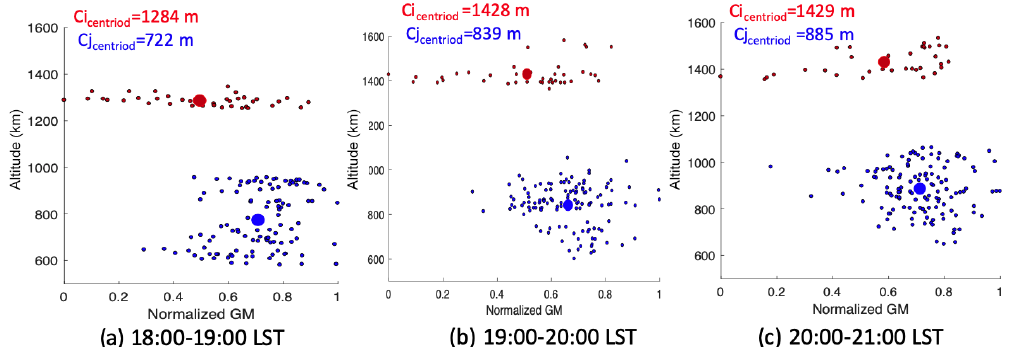
Figure 7. Distribution of altitude and normalized gradient method (GM) values at 18:00–21:00LST. Panels (a–c) indicate hourly